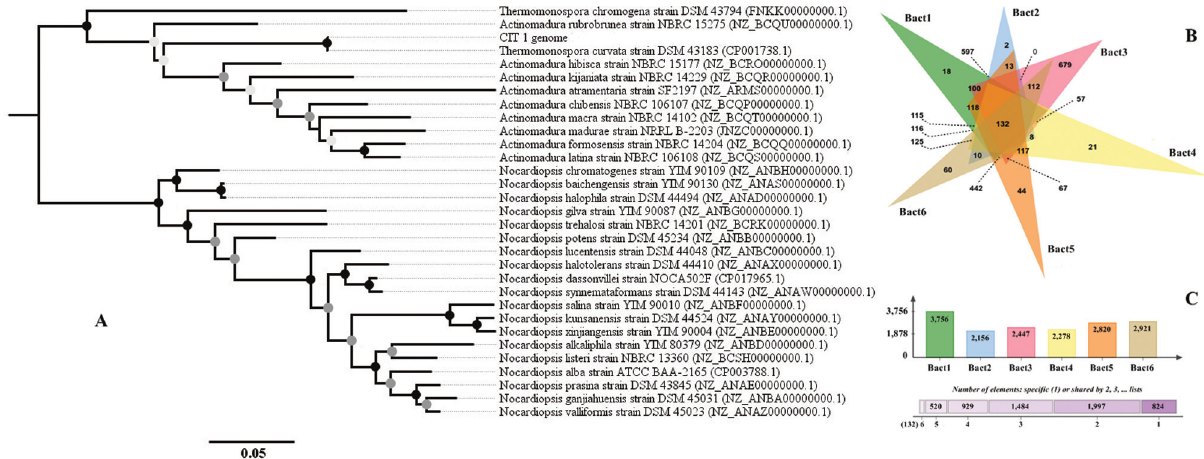
Figure2 -PhylogeneticanalysisusingMaximumLikelihoodtoverifythephylogeneticpositionofthedraftgenomeCIT1( Thermomonospora sp.CIT1) and identification of clusters of orthologous genes using Ortho Venn. (A) Phylogenetic tree demonstrating that the draft genome CIT 1 is related to the clade of Thermomonospora curvata DSM 43183 (Thermomonosporaceae). (B) Clusters of orthologous genes shared among the six phylogenetically re- lated species that make up the Thermomonosporaceae family. The draft genome of Thermomonospora sp. CIT 1 ( Bact1 ) shares 597 clusters of orthologous genes with T. curvata DSM 43183 ( Bact2 ), possessing 18 clusters that are only present in the draft genome of Thermomonospora sp. CIT 1. (C) Total clusters of orthologous genes verified in the six species analyzed, demonstrating that the six bacteria share a total of 132 clusters of orthologous genes among themselves. We retrieved from GenBank the nucleotide sequences of the 23S rRNA , recA , dnaK , dnaJ , dnaJ , atpD and, rpoB genes from 19 speciesof Nocardiopsis ,ninespeciesof Actinomadura ,andtwospeciesof Termomonospora .ThecirclesfoundattheMaximumLikelihoodphylogenetic tree nodes represent the bootstrap support value obtained for each branch. Filled black circles represent bootstrap between 90-100%; filled dark gray cir- cles represent bootstrap between 70-89%; filled light gray circles represent bootstrap between 50-69%. Bact1: draft genoma CIT 1;